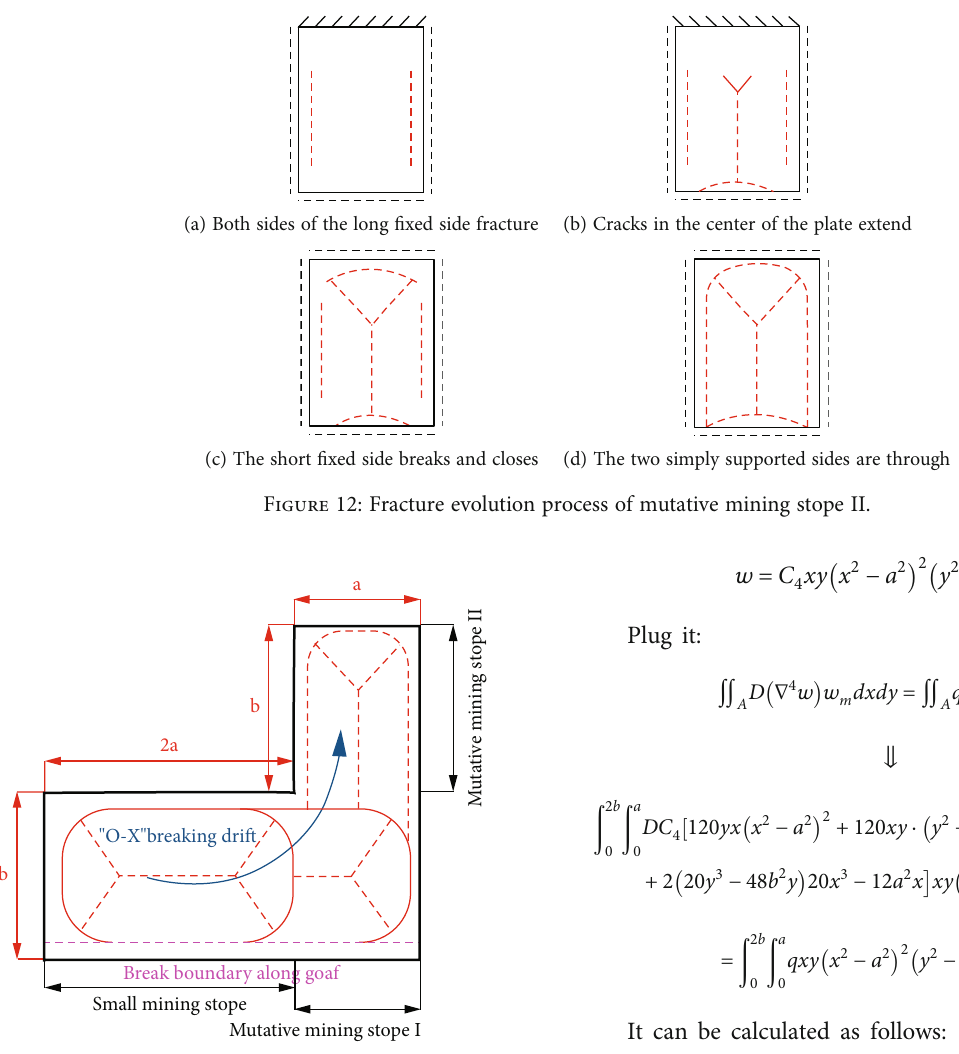
Figure 13: Drift-shaped “ O-X ” fracture of subsequent small mining stope.